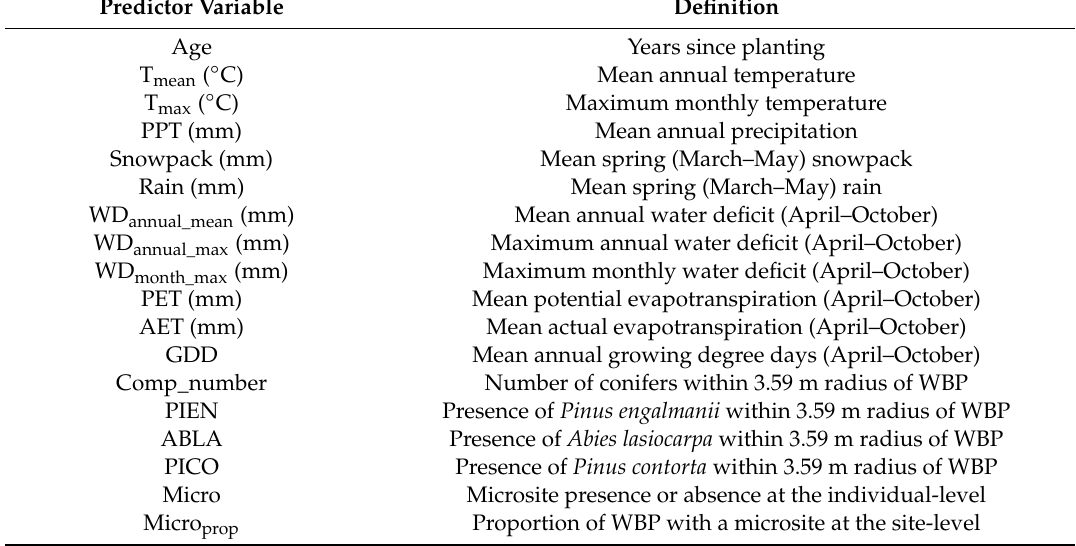
Table 5. Predictor variables and their definitions for use in mixed e ff ects models. All of the climate variables were calculated based on the years since planting at that particular